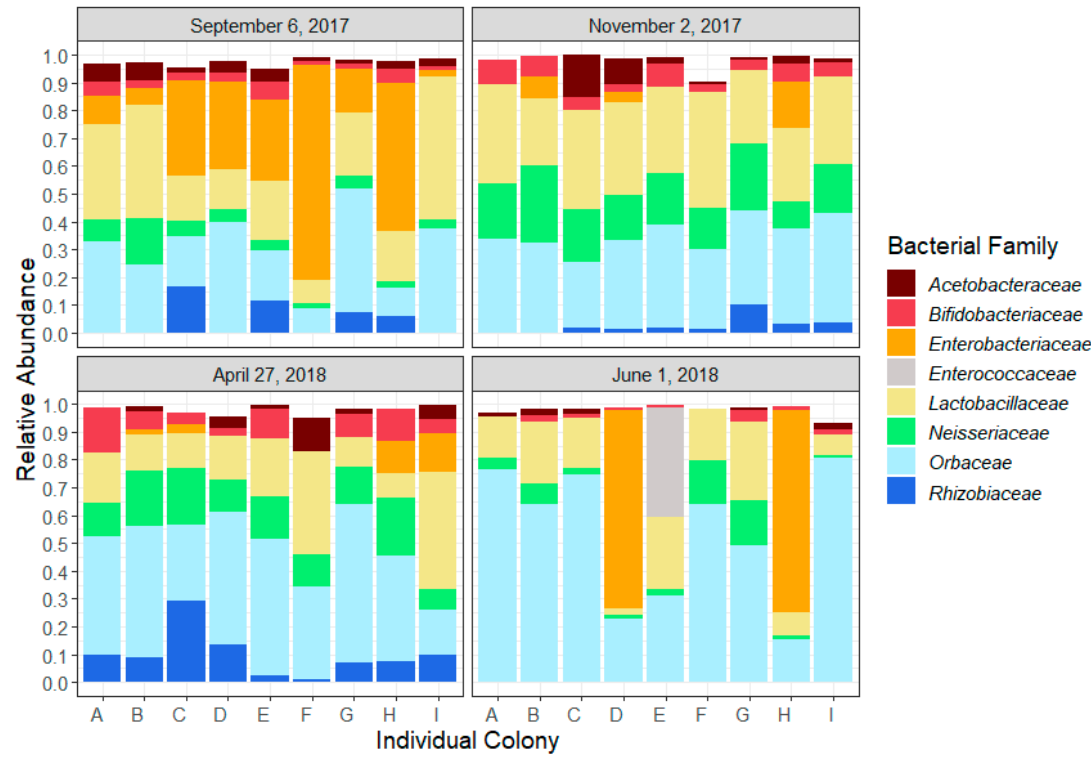
Figure 1. Relative abundance of the core microbiota of the nine colonies (A–I) at the four key sampling moments: September 6, after the last honey flow; November 2, before entering wintering